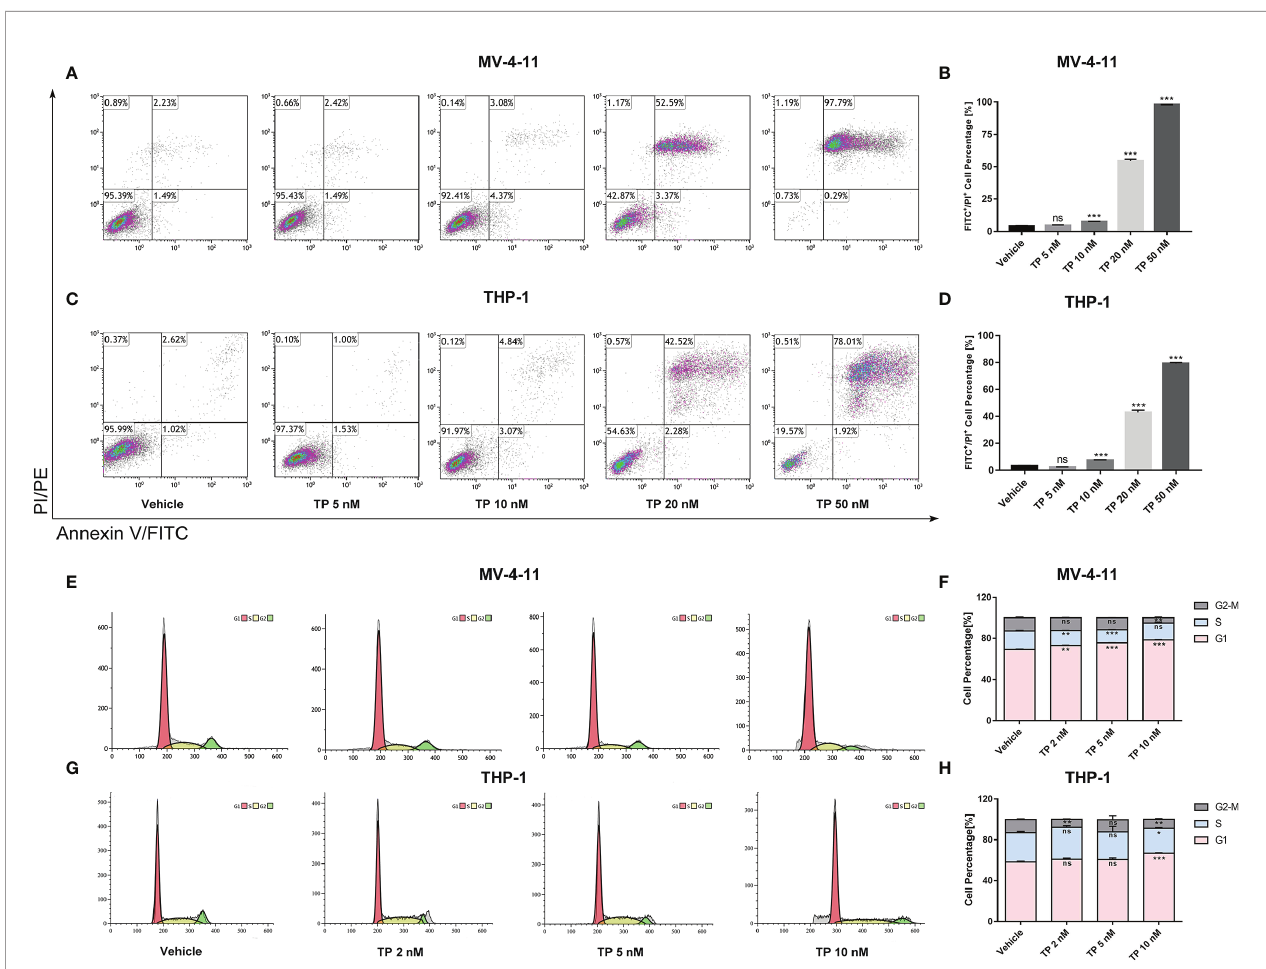
FIGURE 2 | Triptolide induces cell apoptosis and cell cycle arrest in MV-4-11 and THP-1 cells. (A – D) Treatment with triptolide at various concentrations in MV-4-11 (A, B) or THP-1 (C, D) . After 48 hours, apoptotic cells were stained with dual Annexin-FITC/PI staining and examined by fl ow cytometry. (B, D) Bar graphs represent the percentage of cells at early and late stages of cell apoptosis. (E – H) Representative fl ow cytometric histograms, showing cell-cycle distribution in MV-4-11 (E, F) and THP-1 (G, H) , were presented after triptolide treatment for 48 hours. (F, H) Bar graphs represented the percentage of cells in different cell cycle phases. Data are shown as the mean ± SD from three independent experiments. * p < 0.05; ** p < 0.01; *** p < 0.001. ns, no signi fi